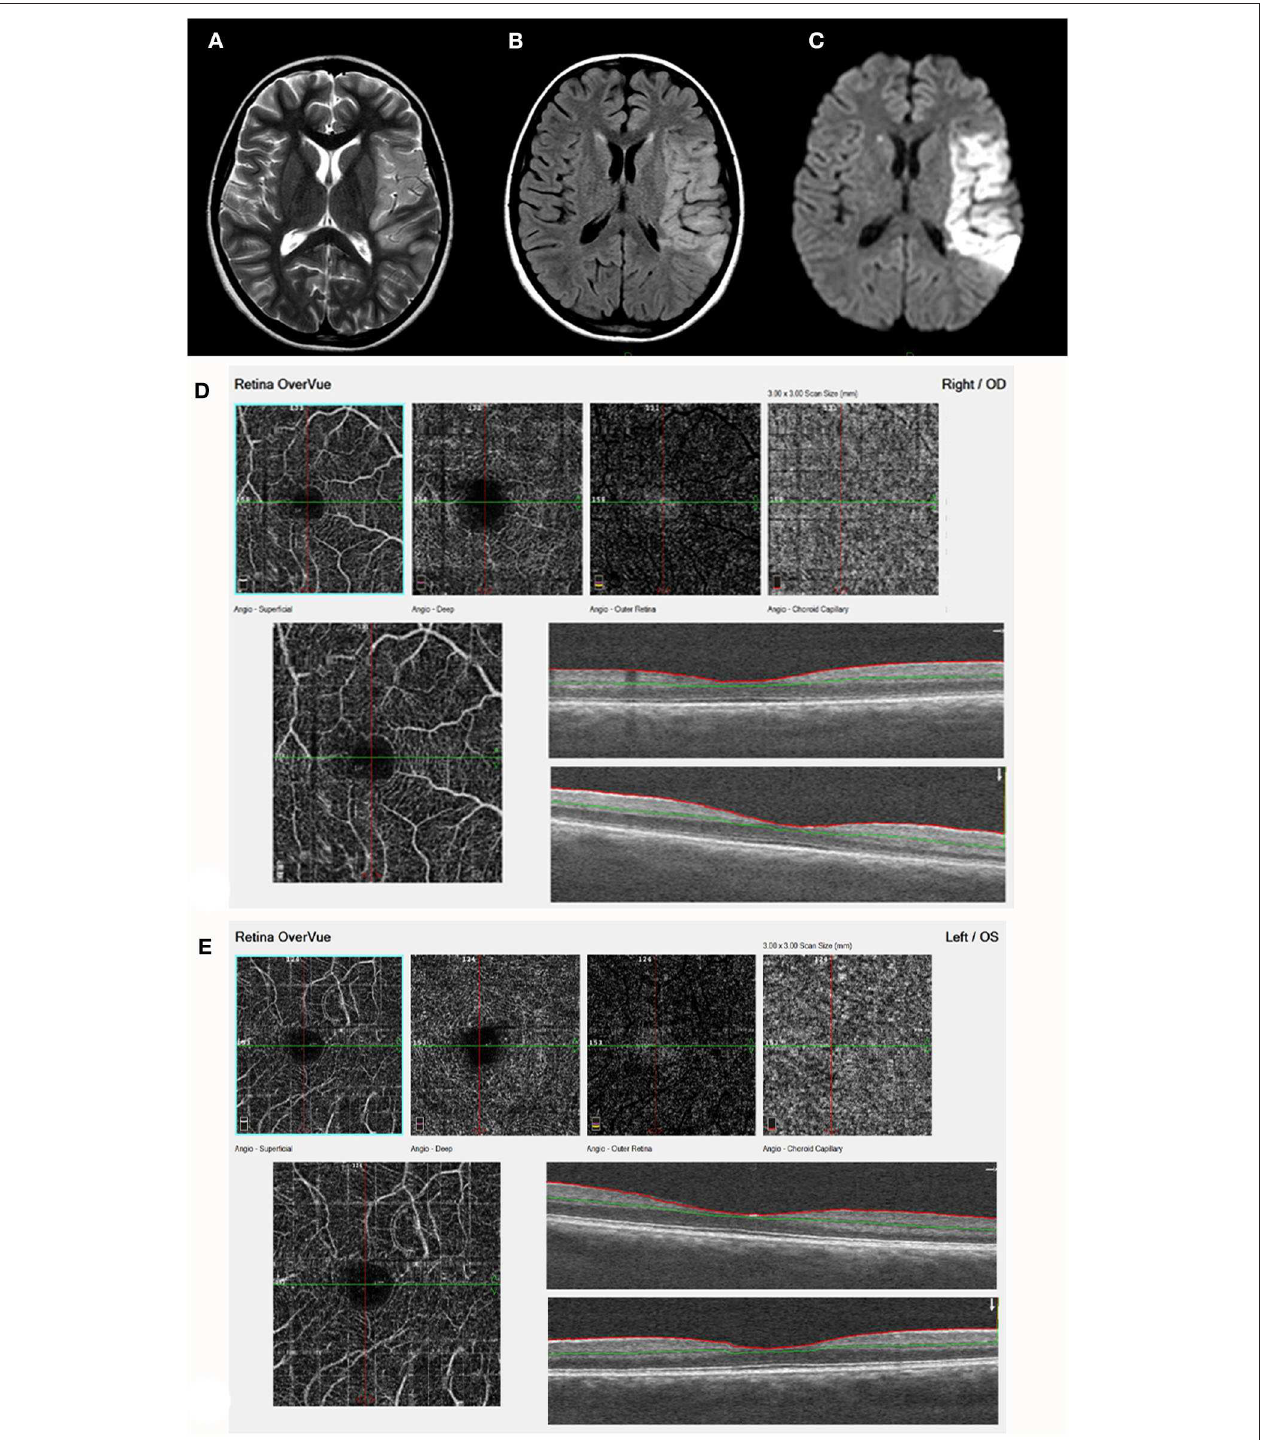
FIGURE 4 | Acute stroke, left MCA territory (patient 17, Table 1 ). (A) T2. (B) FLAIR. (C) DWI - axial studies, acute frontal stroke with restriction on DWI. A left sylvian MCA acute infarct is visualized with restricted diffusion. The finding is visualized on a T2, FLAIR, and DWI images. (D) (right eye) and (E) (Left eye) demonstrate by ocular coherence tomography-angiography (OCT-A). Showing Segmentation of different vascular layers using OCTA: left to right: superficial plexus, deep plexus of the inner retina, outer retina (shows absence of vasculature), and choriocapillaris layer. Severe attenuation of the retinal arteries in the superficial layer is demonstrated in both eyes, Lower line: superficial retina and OCT b-scan image of the retina, showing normal retinal layers.